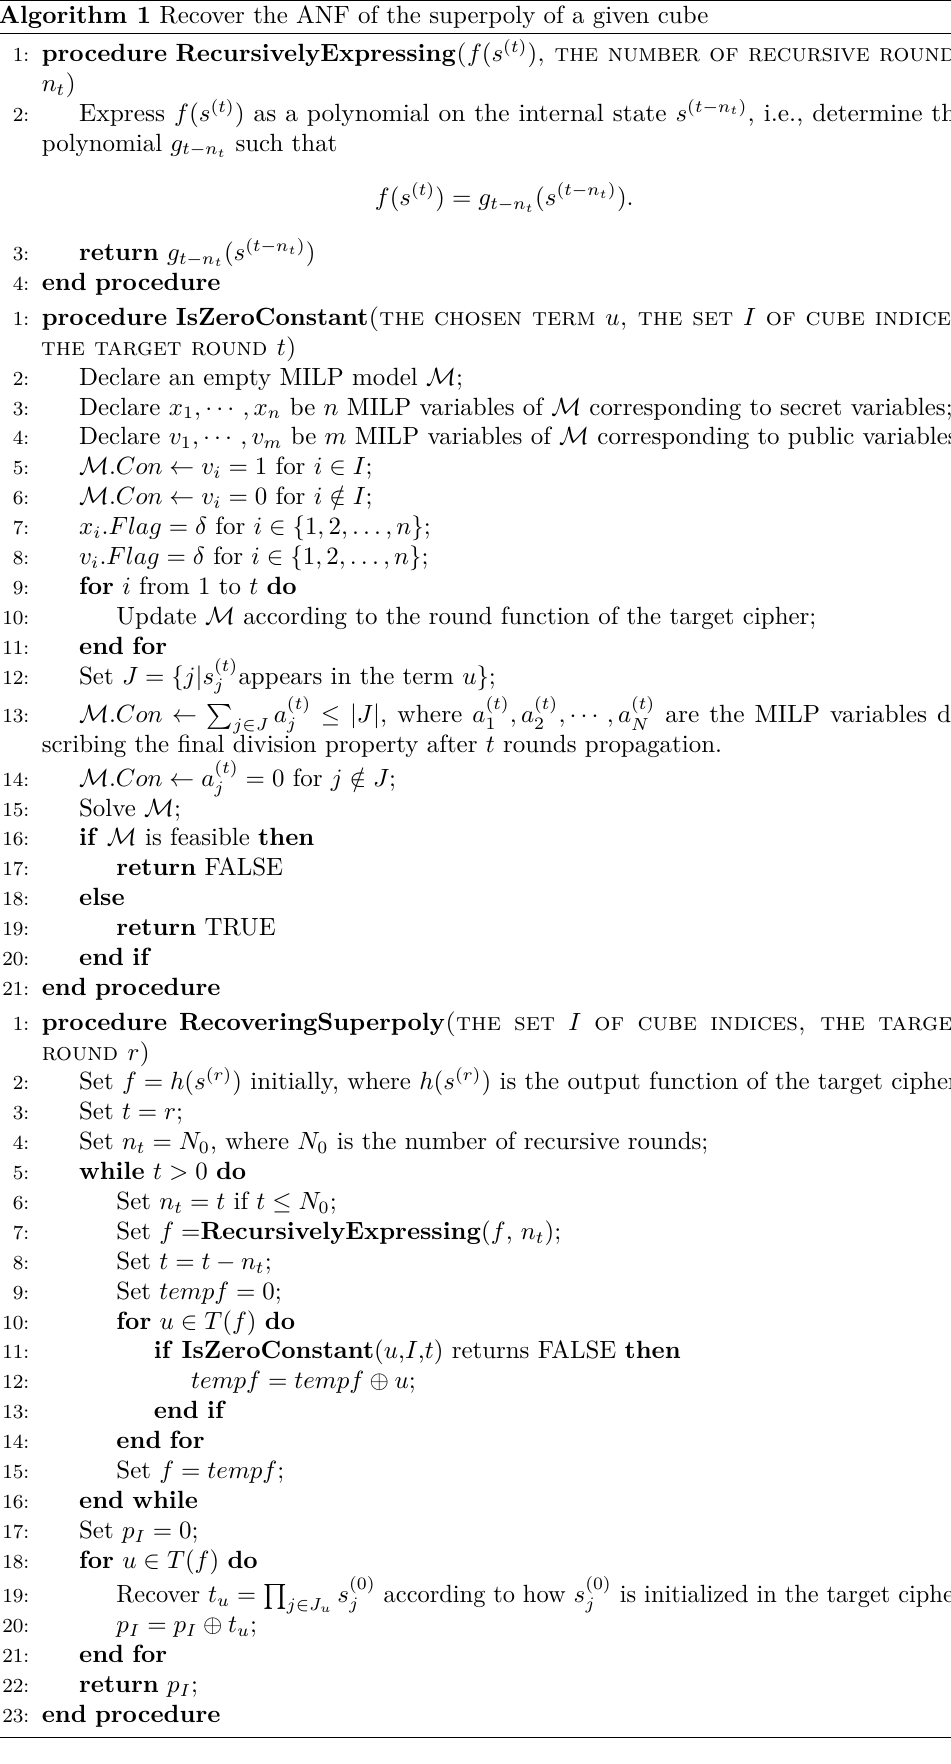
Algorithm 1 Recover the ANF of the superpoly of a given cube